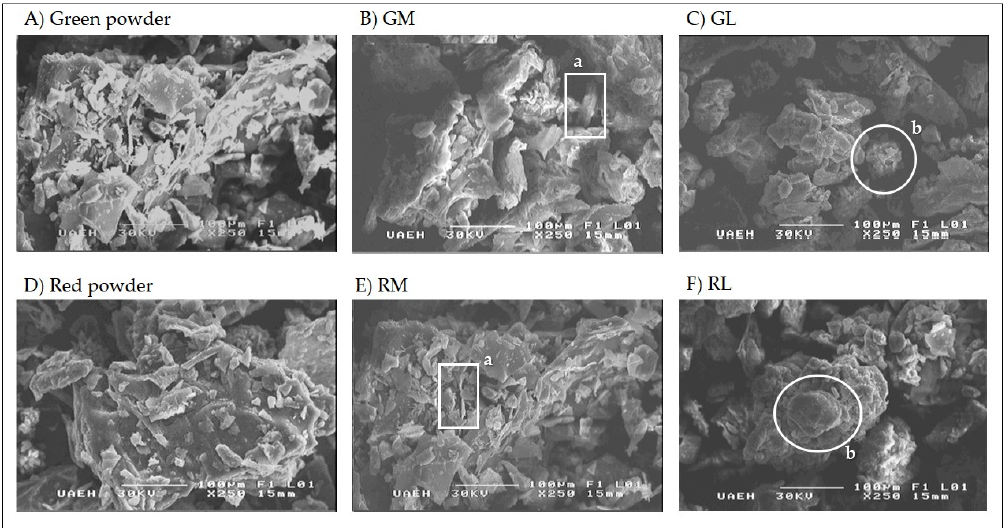
Figure 1. Scanning electron microscopy images of cactus pear ( Opuntia ficus-indica ) residue tablets, 250 × . ( A ) Green cactus pear powder (without excipient); ( B ) GM: green cactus pear residue with microcrystalline cellulose; ( C ) GL: green cactus pear residue with lactose; ( D ) Red cactus pear residue powder (without excipient); ( E ) RM: red cactus pear residue with microcrystalline cellulose; ( F ) RL: red cactus pear residue with lactose. a: Aggregates of microcrystalline cellulose; b: Aggregates of lactose.